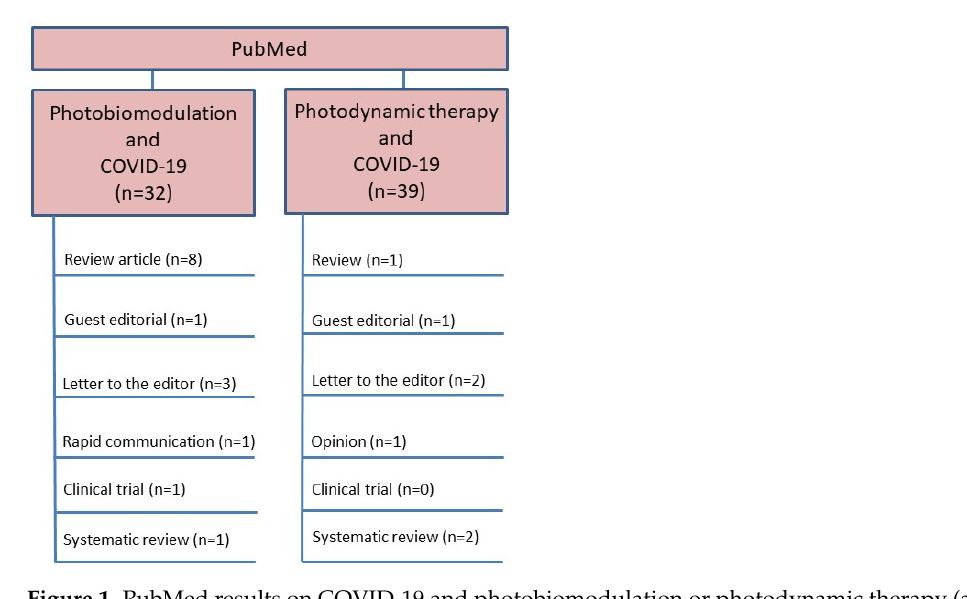
Figure 1. PubMed results on COVID-19 and photobiomodulation or photodynamic therapy (as of June 2021).